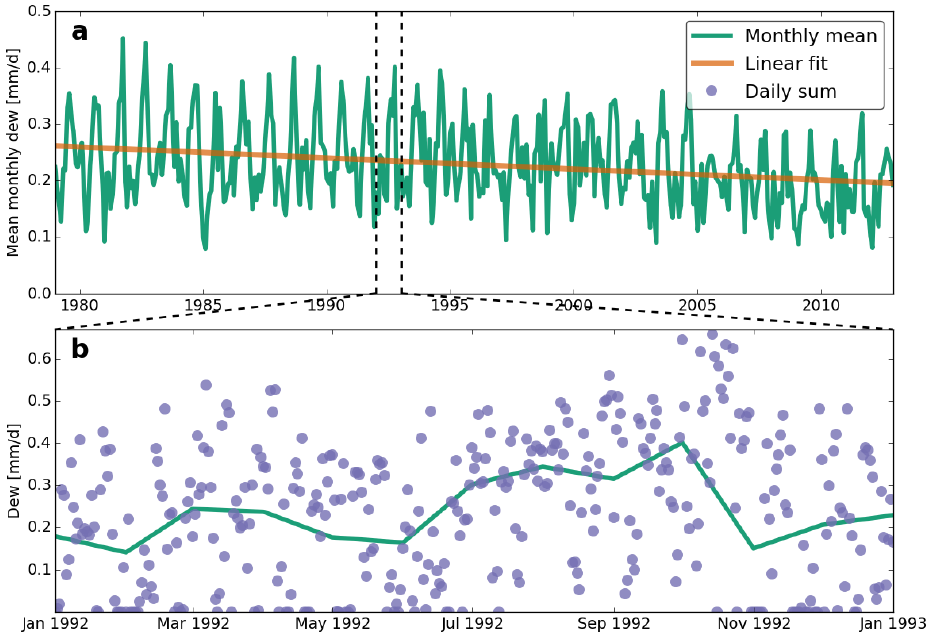
Figure 8. Time series of the modelled dew yield from one grid point, 30.75 ◦ N, 34.5 ◦ E, located in the Negev desert, Israel: (a) the monthly means over the whole data set, as well as a linear fit to the data; (b) the monthly means as well as daily values for the year 1992.